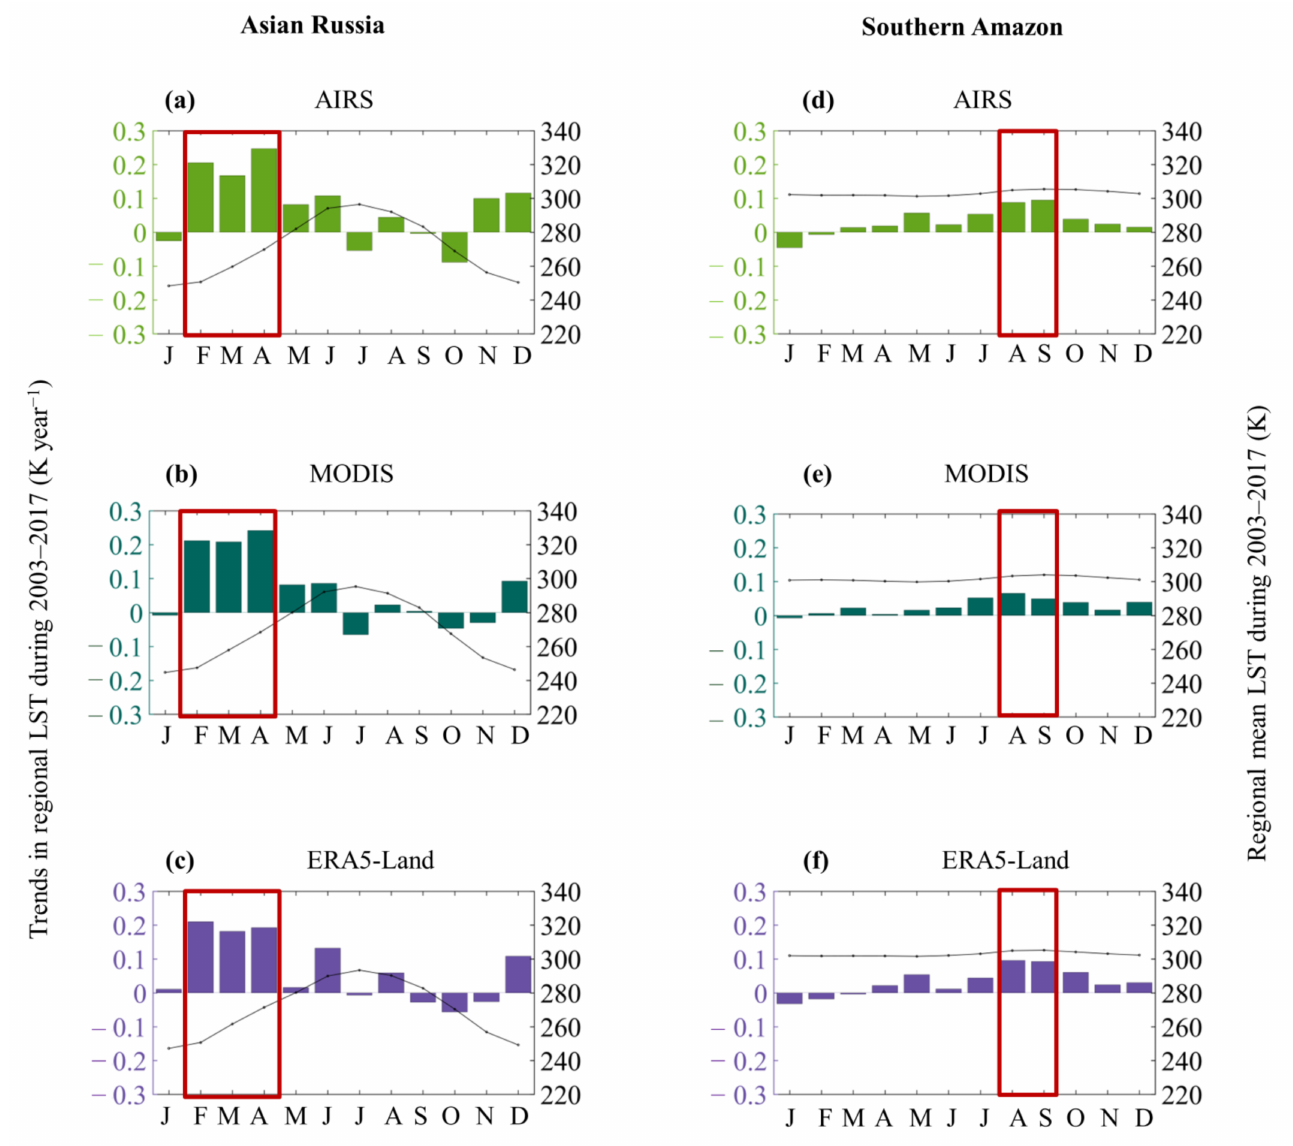
Figure 4. ( a – c ) Trends in monthly LST over Asian Russia for each month from January to December during 2003–2017 (left- hand y-axis) and the average monthly LST during 2003–2017 (right-hand y-axis) based on AIRS, MODIS, and ERA5-Land, respectively. ( d – f ) Same as ( a – c ) but for the southern Amazon. Possible reasons for the strongest LST increases in Asian Russia during February–April and the southern Amazon during August–September are further